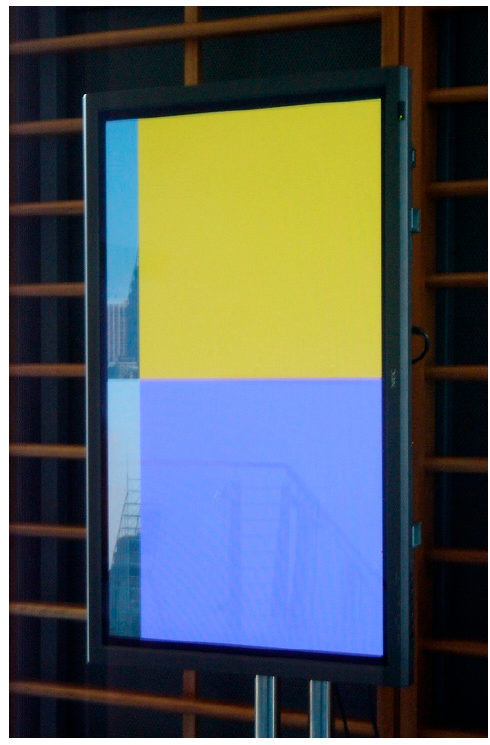
Figure 10. Cities Tango in Belfast. 2009. Photo Ernest Edmonds, © Ernest Edmonds.